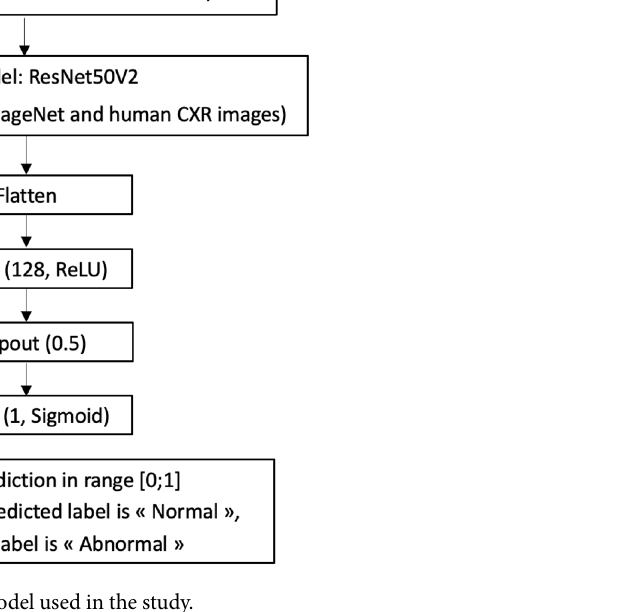
Figure 5. Architecture of model used in the